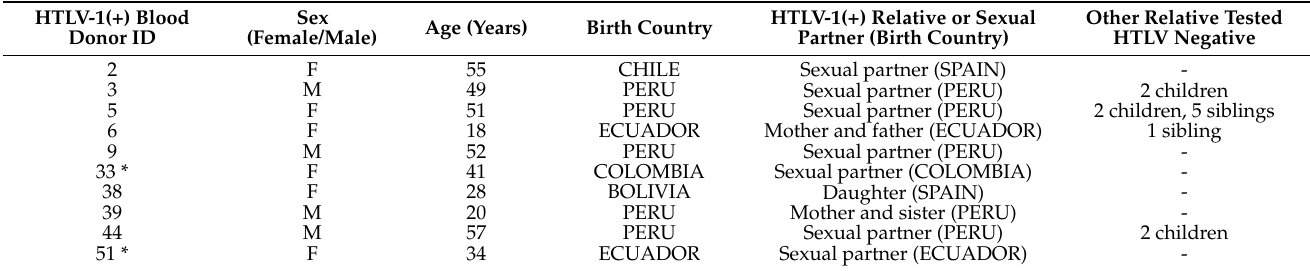
Table 6. HTLV-1(+) relatives or sexual partners of HTLV-1(+) blood donors. HTLV-1(+) Blood Donor